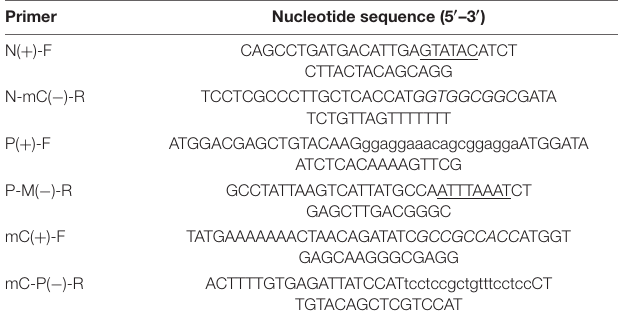
TABLE 1 | Primers used to insert the mCherry gene into the full-length genome of